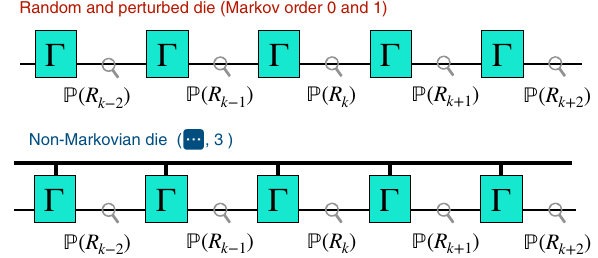
FIG. 2. Random, Markovian, and non-Markovian processes. Top panel shows the circuits for random and Markovian die. In these cases, there are no extra lines of communication between the tosses (represented by boxes). Only the system carries the information forward for a Markov process. The bottom panel shows the non-Markovian die. Here, information is sent between tosses (represented by boxes) in addition to what the system car- ries, which is the memory of the past states of the system (die). This memory is then denoted by the thick line. The memory has to carry the information about the state of the die in the past four tosses to determine the intensity of the next